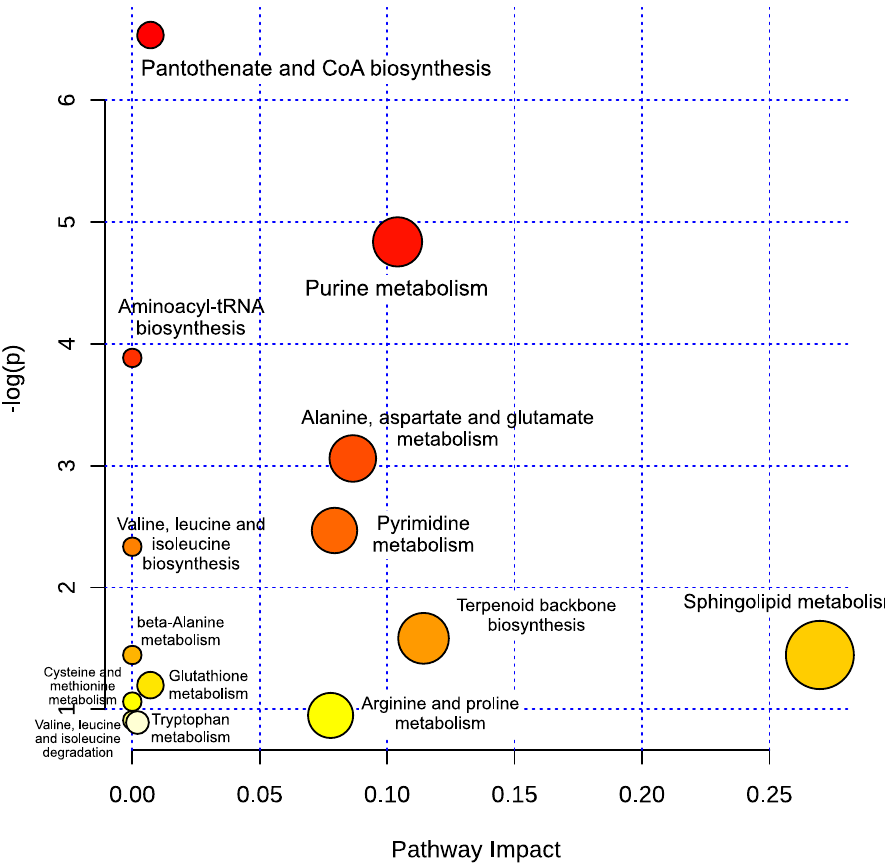
Figure 5. Pathway analysis of compounds di ff erentiating examined mice strains. The Y -axis represents log p -values obtained from the pathway enrichment analysis. The X -axis represents pathway impact values obtained from pathway topology analysis. Node colors and radii are based on p -values and pathway impact values, respectively.